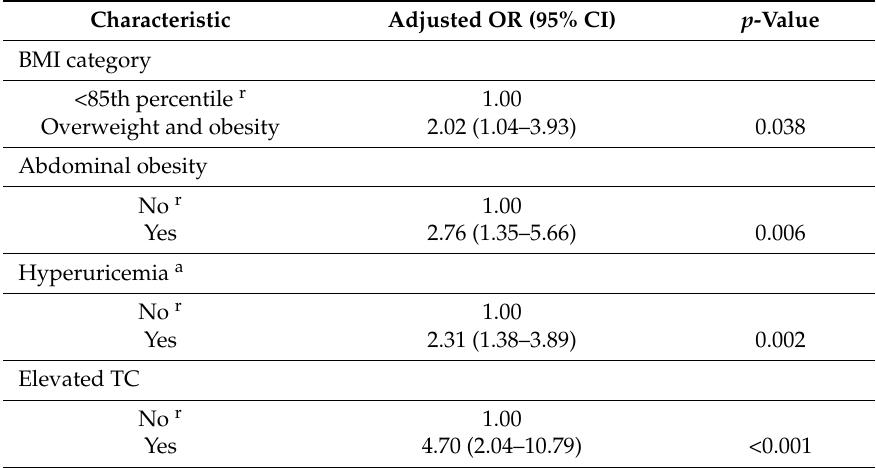
Table 3. Logistic regression analysis of the factors associated with childhood suspected